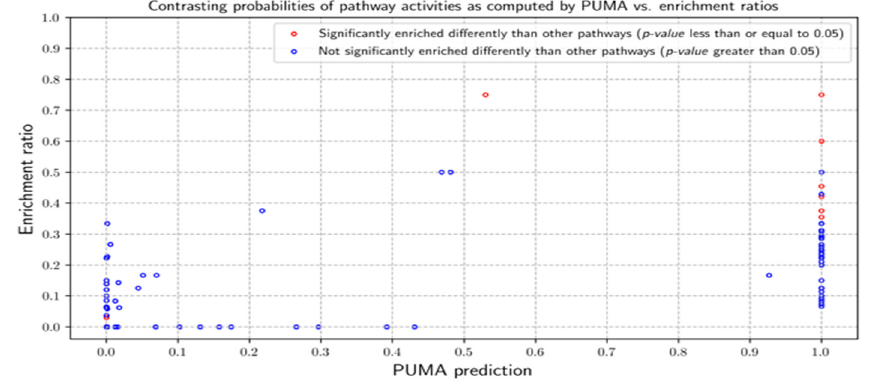
Figure 5. Probability of pathway activities as computed by PUMA vs. enrichment ratios for CHO cell. Each data point is marked as either statistically enriched (red) or non-statistically enriched (blue) based on a Fisher’s Exact Test p -values of 0.05.